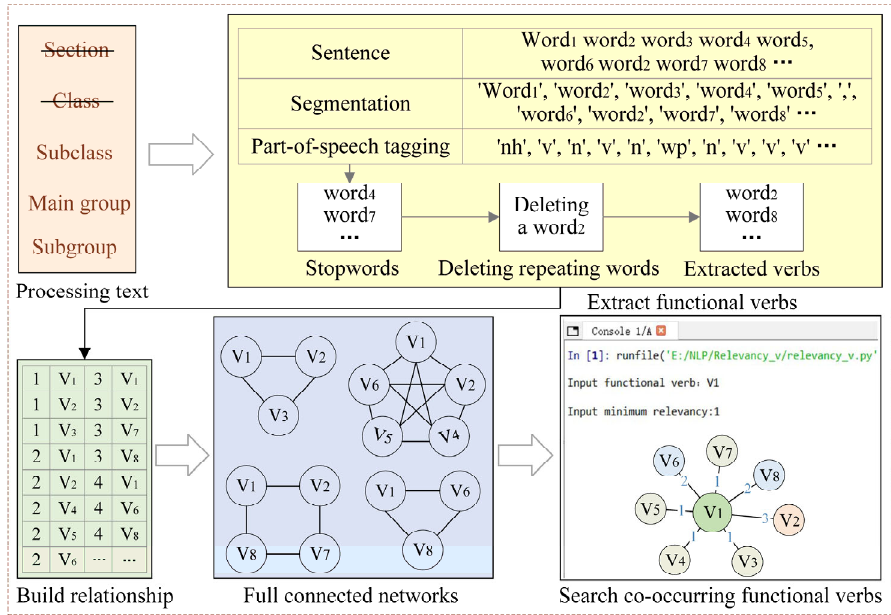
Figure 5. The process of associative verb extraction and search.